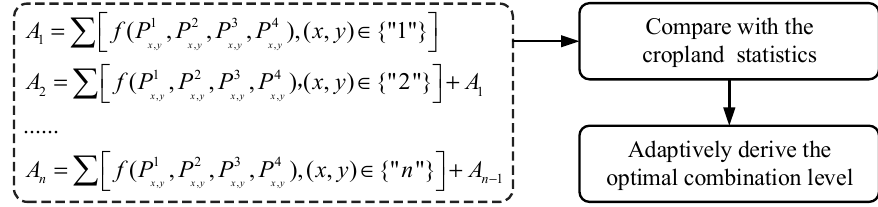
Figure 5. Using cropland statistics to obtain the optimal combination level.